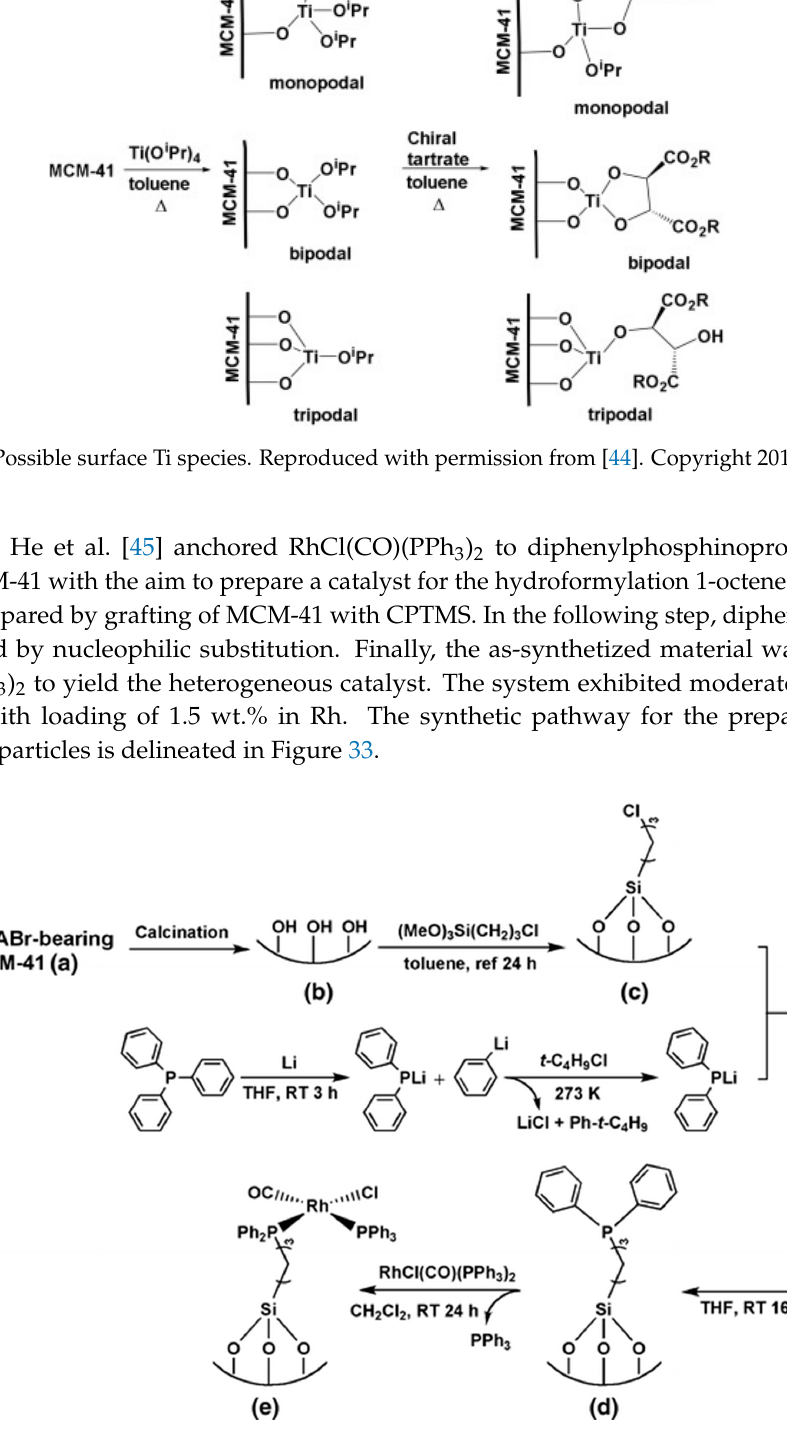
Figure 33. Preparation of M–PrPPh2Rh catalyst. Reproduced with permission from [45]. Copyright 2008